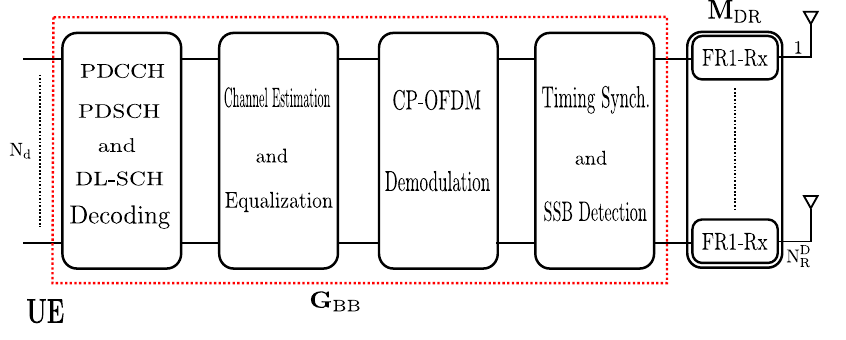
Figure 2. Baseband UE